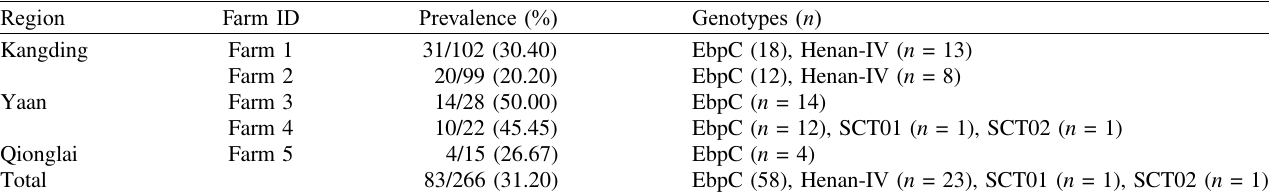
Table 2. Occurrence and genotypes of E. bieneusi in Tibetan pigs from different cities in southwest China. Region